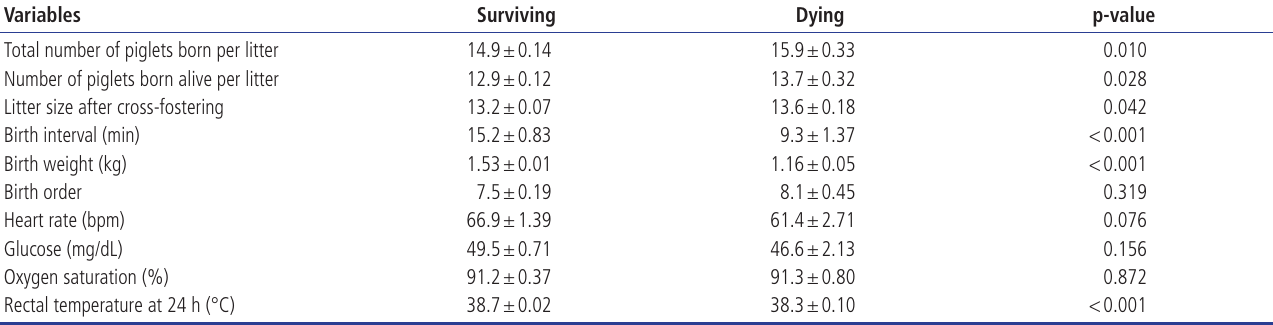
Table 4. Potential indicators for piglet pre-weaning mortality (means±standard error of the mean) comparing surviving piglets from birth to day 21 of lactation (n = 603) with dying piglets (n = 87)